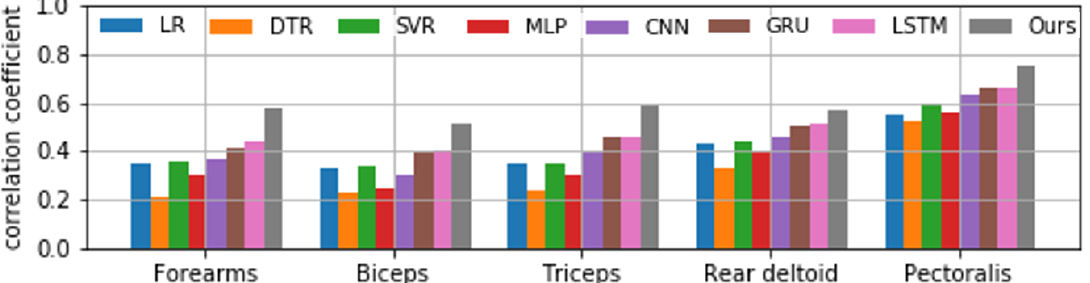
Figure 10. Comparison of correlation coefficients for each model.